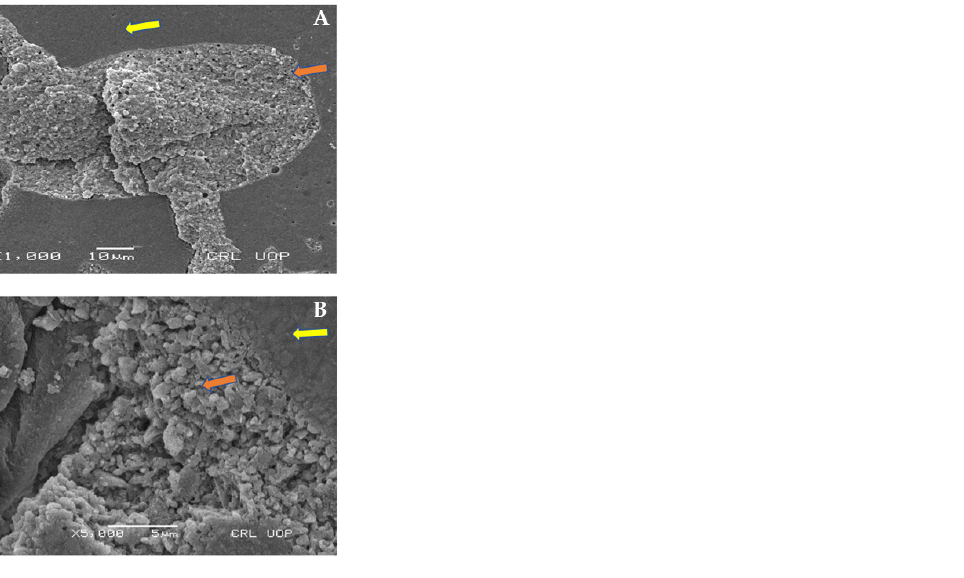
Figure 7. Scanning electron microscopy images showing failure modes of GIC + Z350 (Group A), mixed failure under scanning electron microscope. ( A ) Yellow and orange arrow indicates mixed failure region in low magnification 1000×. ( B ) The magnified cohesive and adhesive failure regions at 5000×.